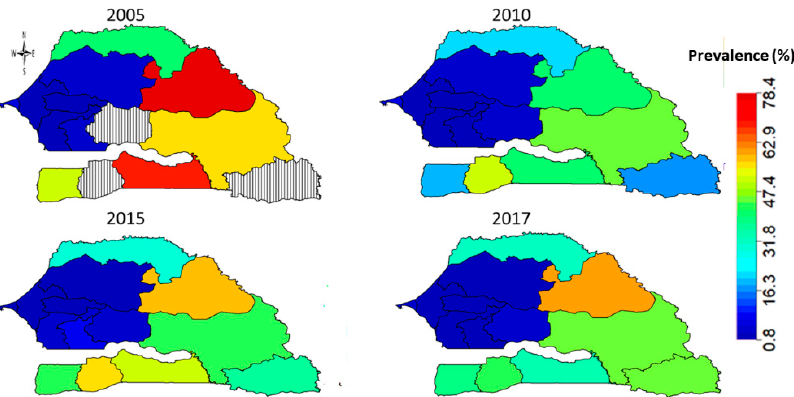
Figure 2. Evolution of FGM/C prevalence among girls aged 0–14 years across the 14 administrative regions of Senegal from 2005 to 2017.